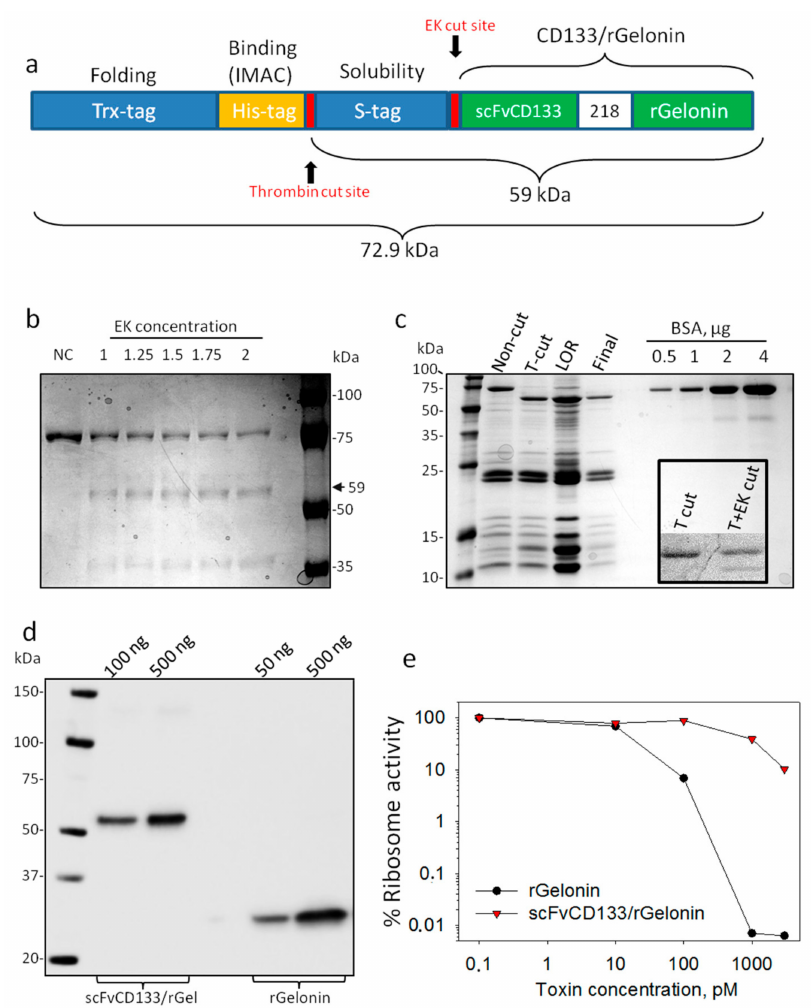
Figure 1. Design, expression and RIP activity of scFvCD133 / rGelonin. ( a ) Schematic representation of the recombinant scFvCD133 / rGelonin fusion construct including the enterokinase (EK) and thrombin cut sites. ( b ) Coomassie Blue stain of non-cut (NC) and EK cut material with increasing concentration of enterokinase. ( c ) Coomassie Blue stain of non-cut and thrombin cut (T-cut) material, the material left on resin (LOR) upon His-tag removal (concentrated), and the final cut and purified product (Final). Increasing concentrations of bovine serum albumin (BSA) were used as control. Inserted panel under the BSA bands shows an attempt on cutting the final product with EK upon T-cut. ( d ) Western blot immunodetection of scFvCD133 / rGelonin and rGelonin. The immunoblot is representative of three individual experiments with di ff erent toxin concentrations. ( e ) Ribosome-inactivating protein activity of scFvCD133 / rGelonin and rGelonin measured by using the cell free Rabbit reticulocyte lysate assay. Representative single well-based data from three independent